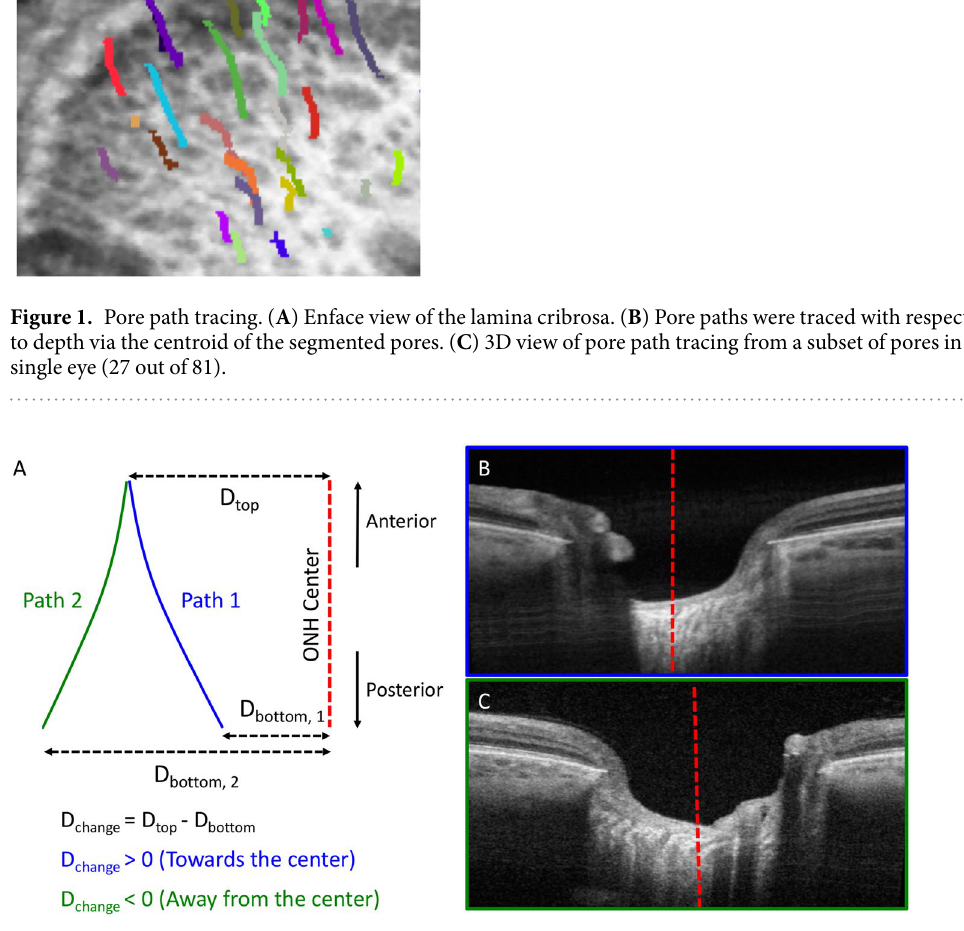
the distribution. Linear mixed effects analyses were used to determine how (1) average pore depth tracked, (2) pore movement towards the center and (3) how pore tortuosity was affected by diagnosis and disease severity as assessed by visual field mean deviation (VF MD). The linear mixed effects models were random intercept models, with the random effect of each eye accounting for the expected autocorrelation between eyes.